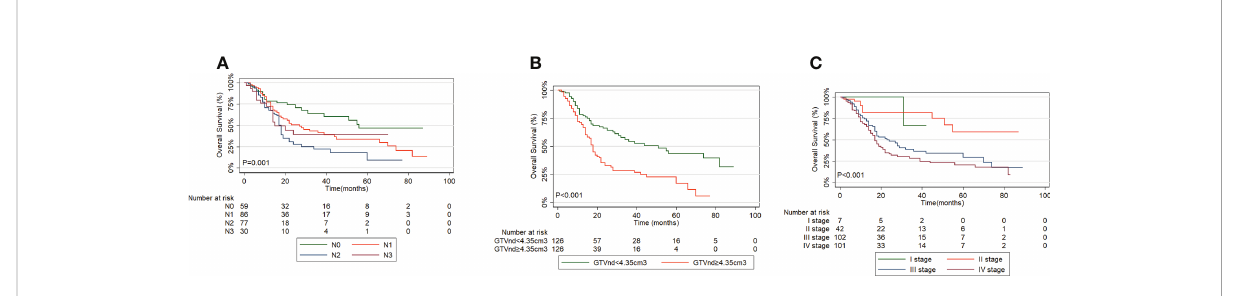
FIGURE 4 Overall Survival curves for ESCC patients treated with dCCRT according to: (A) N stage, (B) GTVnd, (C) TNM stage